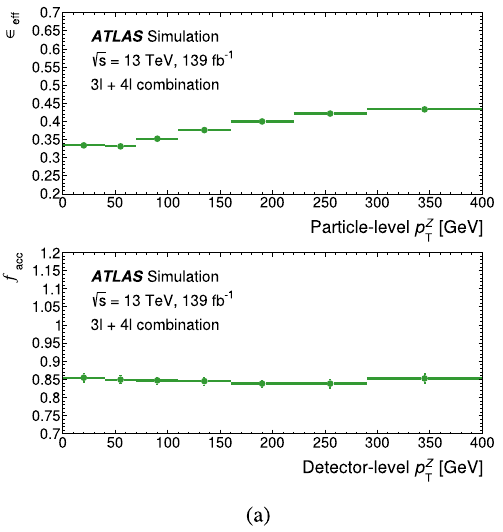
Fig. 8 The efficiency ( (cid:14) eff ) and acceptance ( f acc ) correction factors for the a particle-level and b parton-level measurements as a function of the p T of the Z boson in the combination of the trilepton and tetralep-